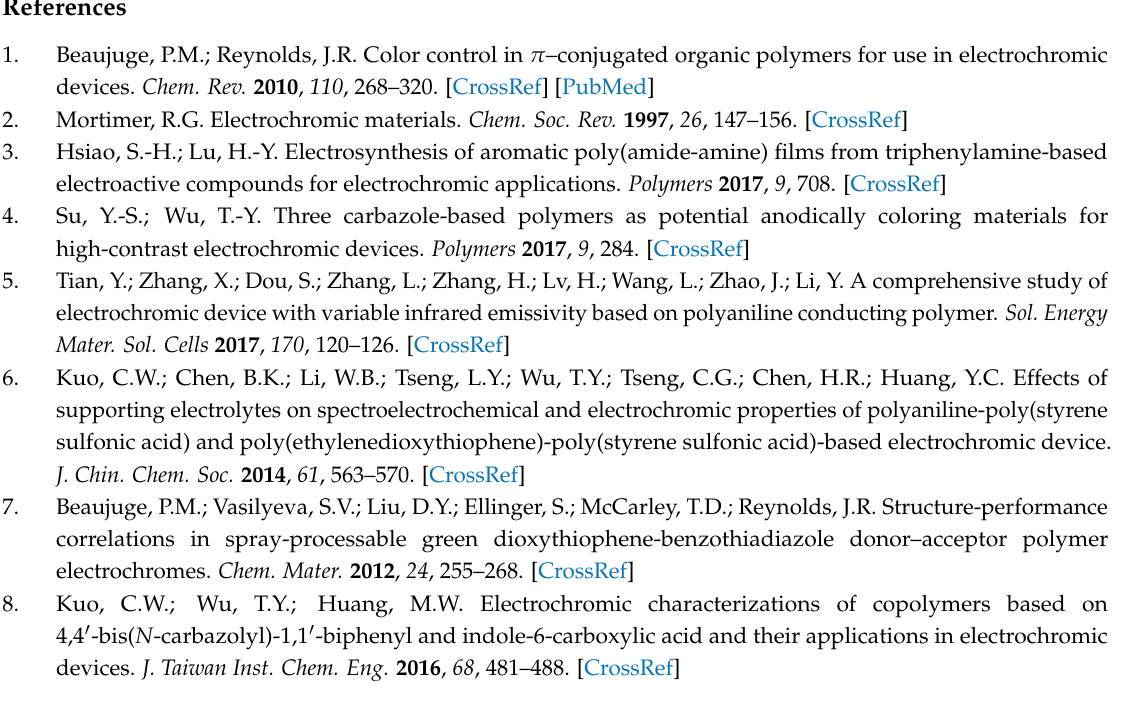
Table S1: Colorimetric values of the copolymer films at various potentials in solution state; Table S2: Colorimetric values of ECDs at various potentials; Figure S1: Open circuit stability of (a) P(MPS- co -TTPA)/PProDOT-Et 2 ECD monitored at 576 nm, (b) P(MPO- co -TTPA)/PProDOT-Et 2 ECD monitored at 580 nm, and (c) P(ANIL- co -TTPA)/PProDOT-Et 2 ECD monitored at 582